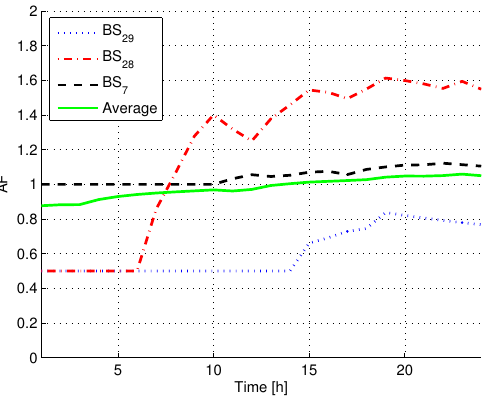
Figure 7. AF evolution vs. time.